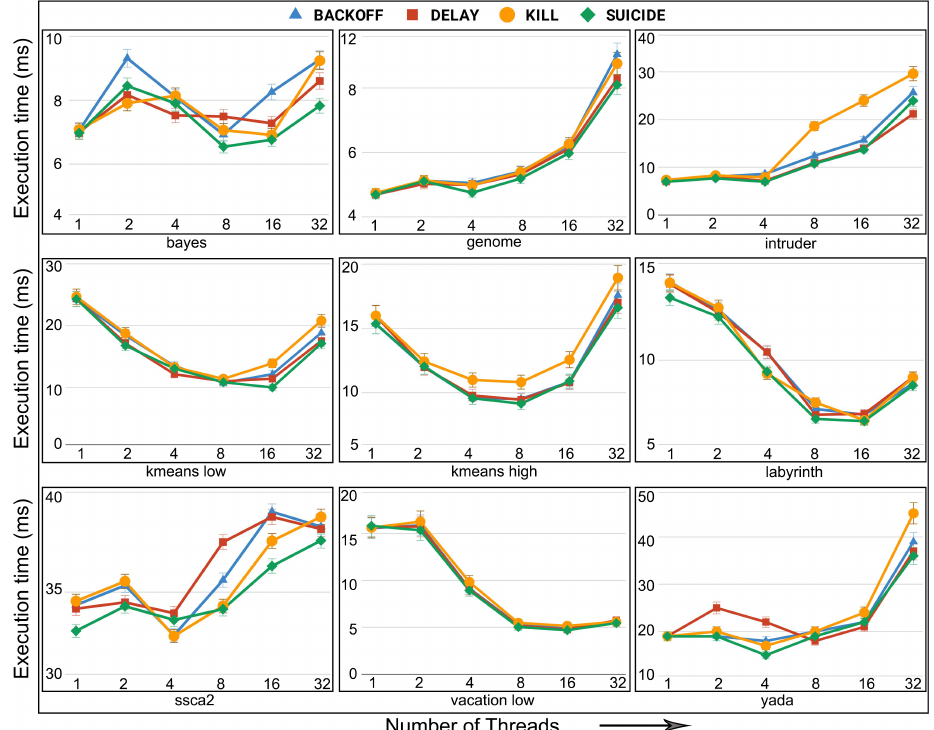
Figure 28. Execution time in STAMP benchmarks for Adaptive _ ETL for four different contention management techniques in non-persistent